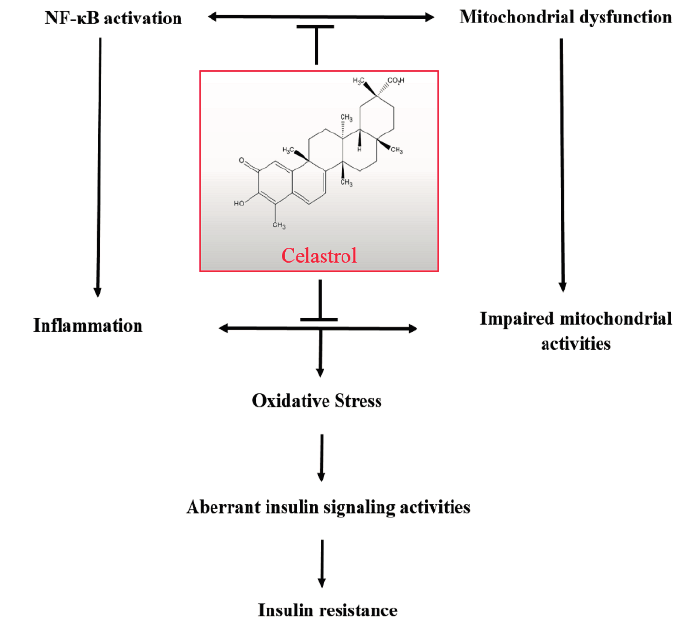
Figure 10. Schematic representation of the mechanistic action of celastrol on mitochondrial dysfunction-induced insulin resistance in human skeletal muscle